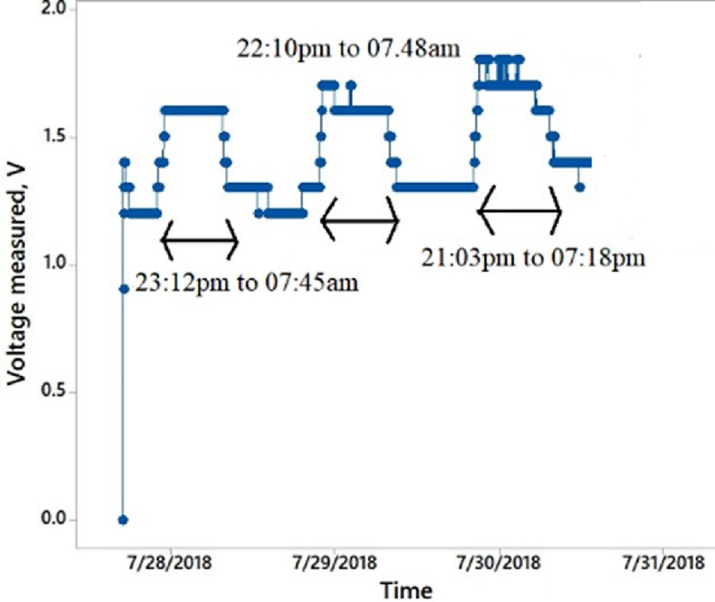
Fig 19. Voltage value of a capacitor, which is charged by a series connection between two leaves which passing through the stem of Aloe Vera over a period of 3 days.